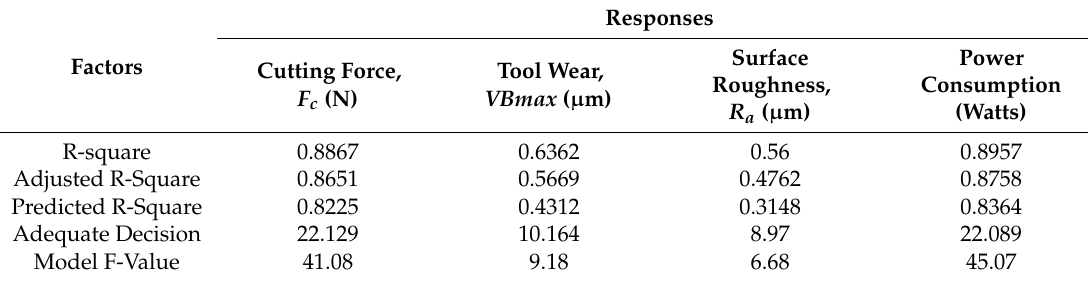
Table 3. Analysis of variance (ANOVA)